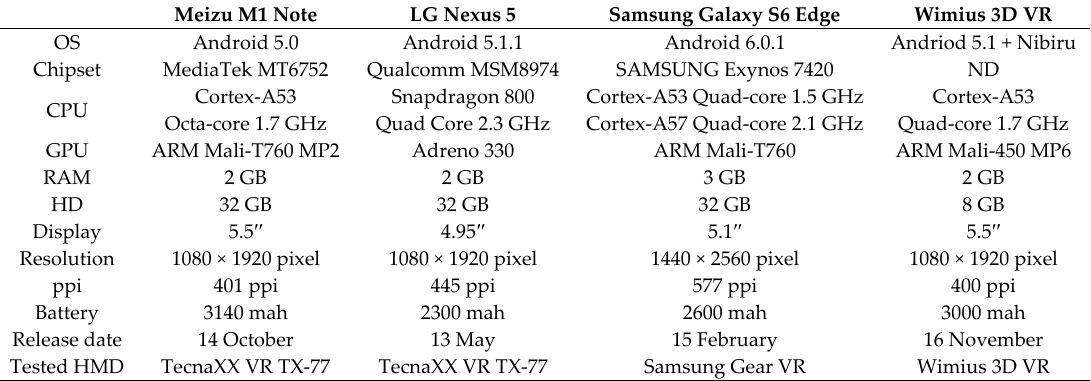
Table 1. Devices comparison. The chart summarizes main features of each